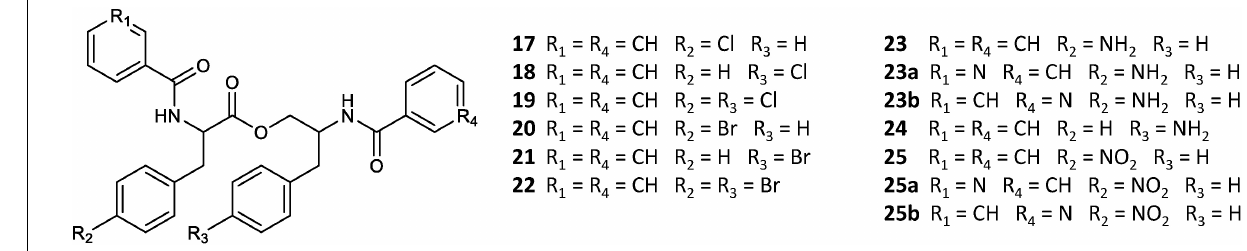
FIGURE 9 | Structural overview of HRMS/MS characterized asperphenamate analogs from P. astrolabium upon para-substituted phenylalanine supplement study.